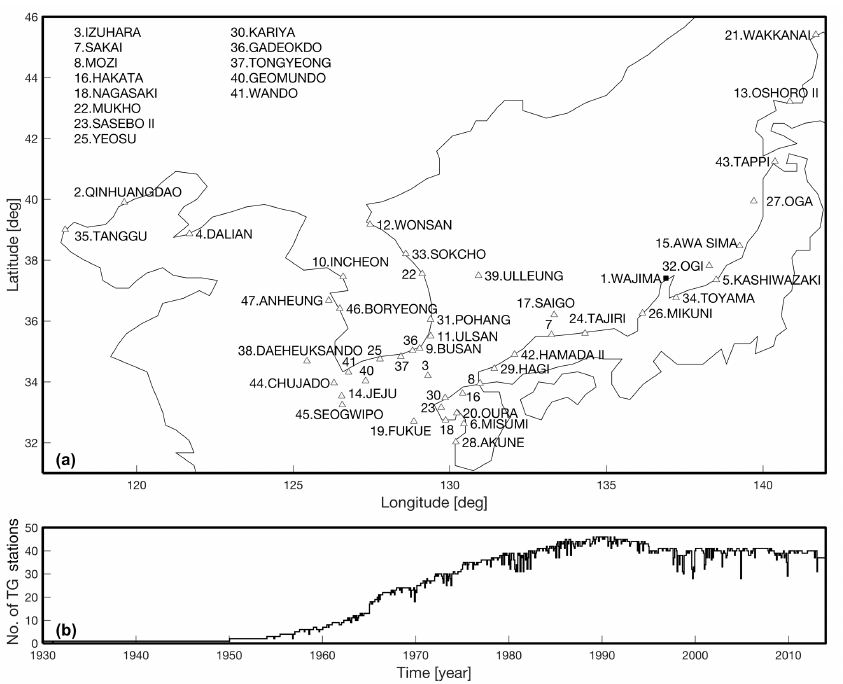
Figure 1. (a) The locations of tide gauge station used in this study around the Korean Peninsula. The black square is Wajima station which has the longest record length (1930–present); (b) the number of tide gauge stations provided by the Permanent Service for Mean Sea Level (PSMSL) around the Korean